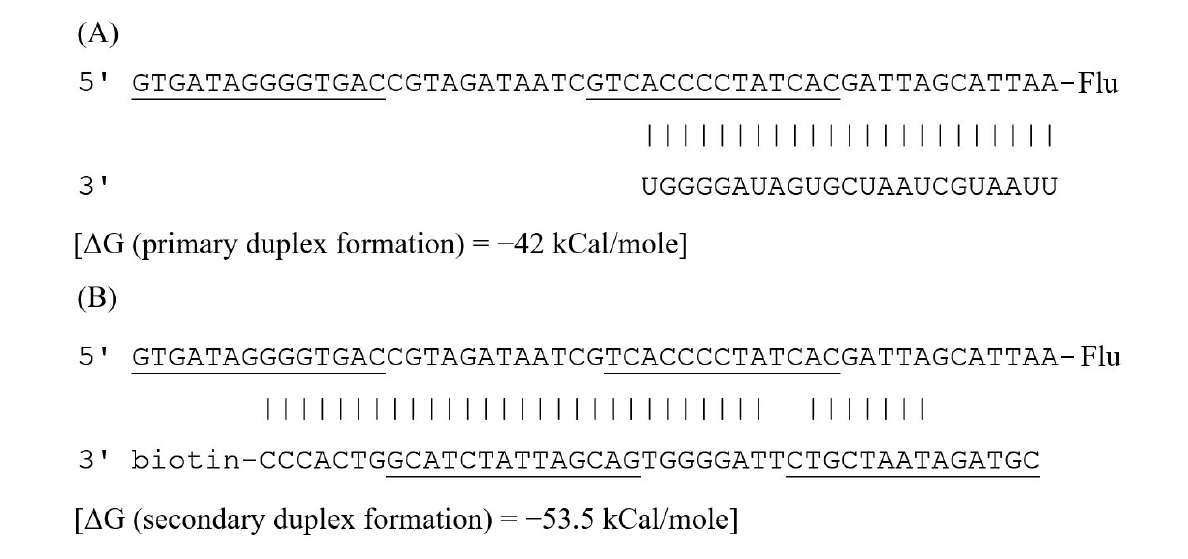
Figure 3. Schematic illustration of the formation of ( A ) primary and ( B ) secondary duplexes produced in the chemiluminescent assay based on the mismatched catalytic hairpin assembly reaction for microRNA-155 detection. The underlined nucleotide fragments are involved in the stems of the hairpin structures. Modeling of the hairpin structures and ∆ G assessment were performed using OligoAnalyzer 3.1 software.